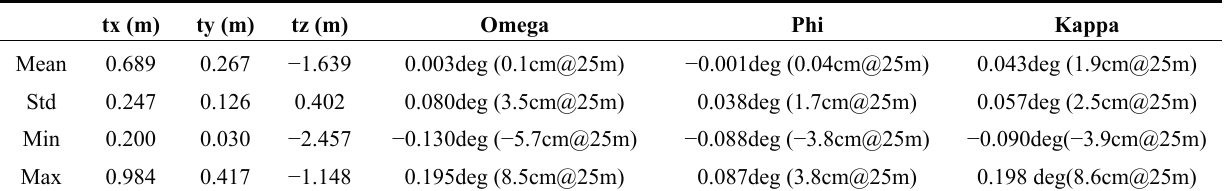
Table 2. The summary of transformation parameters for MLS/MLS